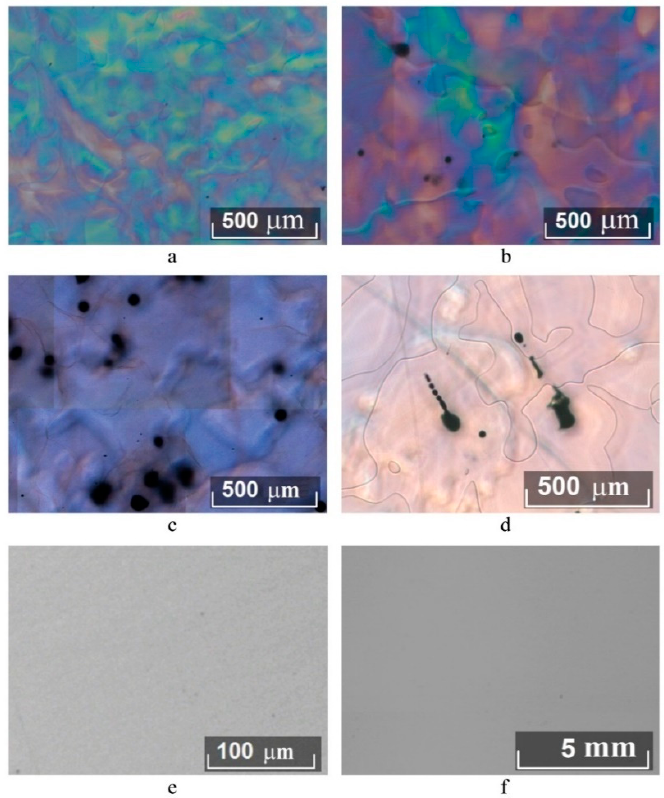
Figure 2. Optical deviations and macrodefects in the form of “channels” in crystals LiNbO 3 :B: ( a )–(~6.20 ⋅ 10 –5 wt% [B] in the crystal cone, density of “channels” ~1.7 pcs/mm 2 ); ( b )–(~6.20 ⋅ 10 –5 wt% [B] in the cone of the crystal, the density of “channels” ~3.8 pcs/mm 2 ); ( c )–(~1.44 ⋅ 10 –5 wt% [B] in the cone of the crystal, the density of “channels” ~5.6 pcs/mm 2 ), ( d )–(~6.20 ⋅ 10 –5 wt% [B] in the cone of the crystal, the density of “channels” ~5.6 pcs/mm 2 ), after heat treatment; ( e )–(~6.20 ⋅ 10 –5 wt% [B] in the cone of the crystal), after transformation into a single-domain state; ( f )–(~1.1 ⋅ 10 –4 wt% [B] in the cone of the crystal), after transformation into a single-domain state. All images are taken in DIC mode.